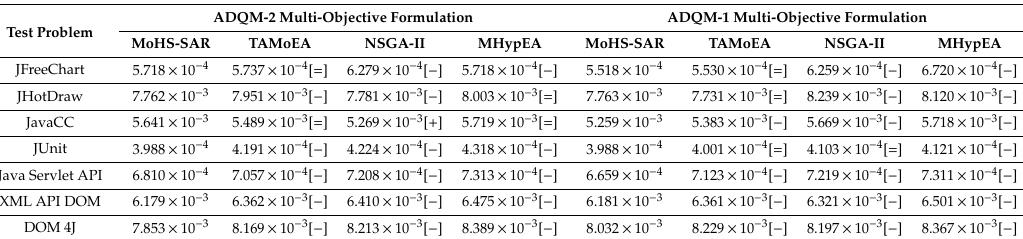
Table 7. IGD as an assessment